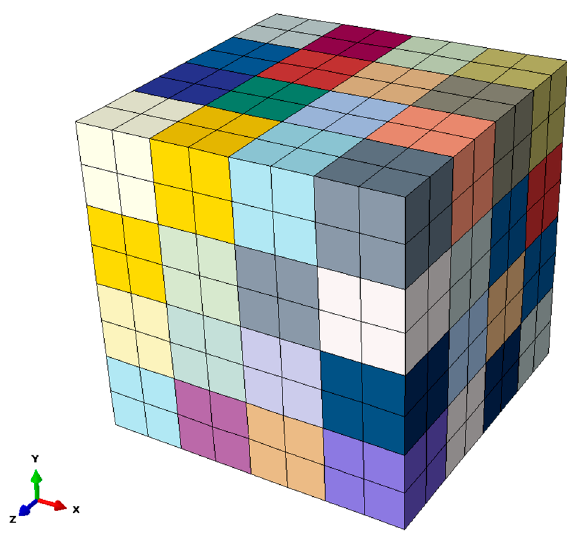
Figure 5. Finite element model used for crystal plasticity (CP).